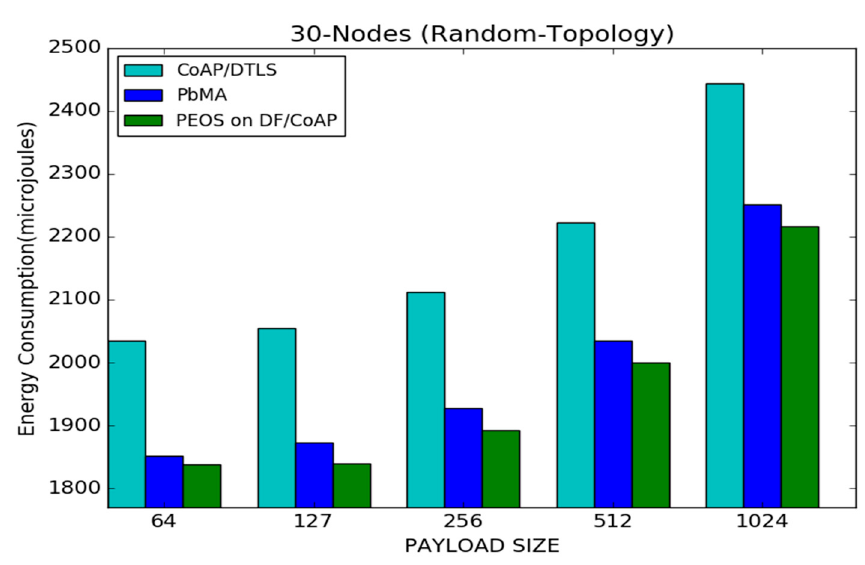
Figure 8. Payload size vs. average energy consumption for 30 node topology.